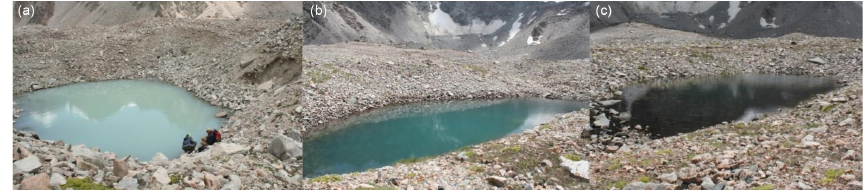
Figure 5. Thermokarst lakes of varying age in the moraine complex below the Adygine glacier. These small lakes are situated at ∼ 3450ma.s.l., all within a few hundred metres of each other. Differences in lake water turbidity or colour suggest existing (left) or missing (right) recharge from melting buried ice. Photo: K. Falatkova (2017).